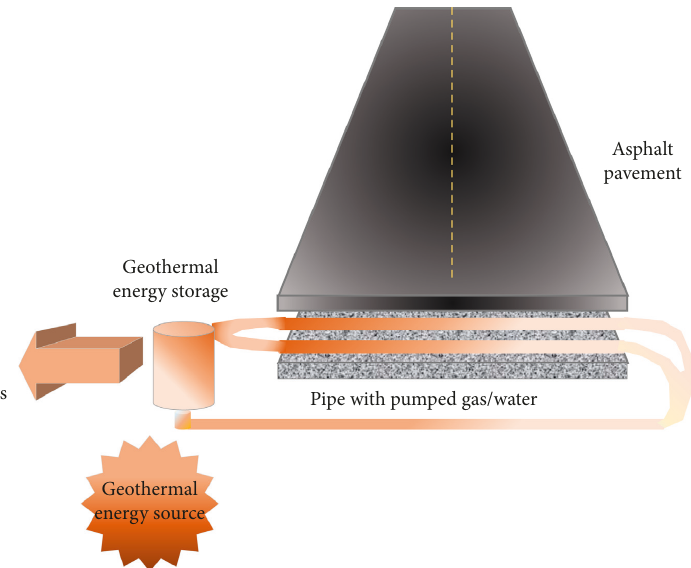
Figure 7: Geothermal pavement (based on